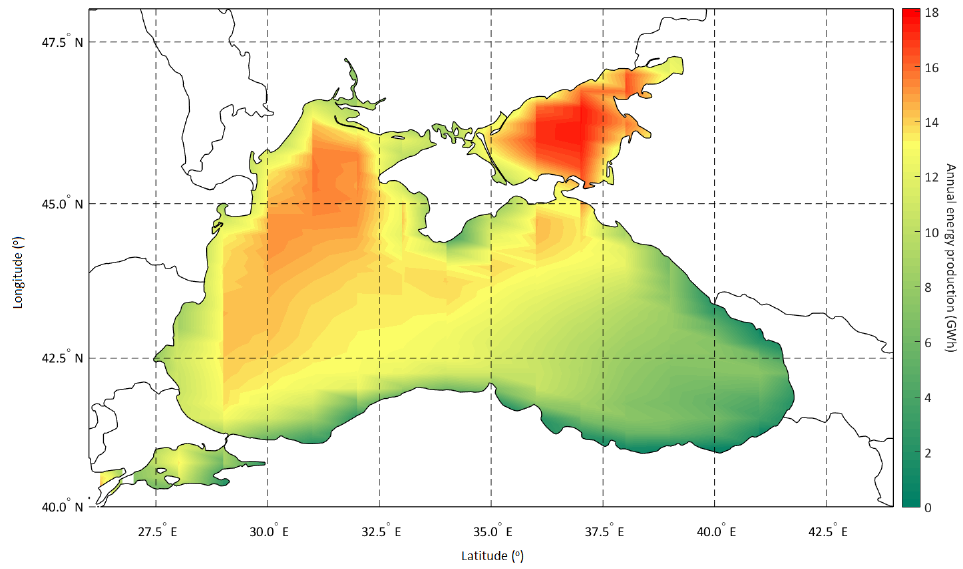
Figure 12. Airborne 5 MW—annual energy production (in GWh) expected for the U414 wind conditions.